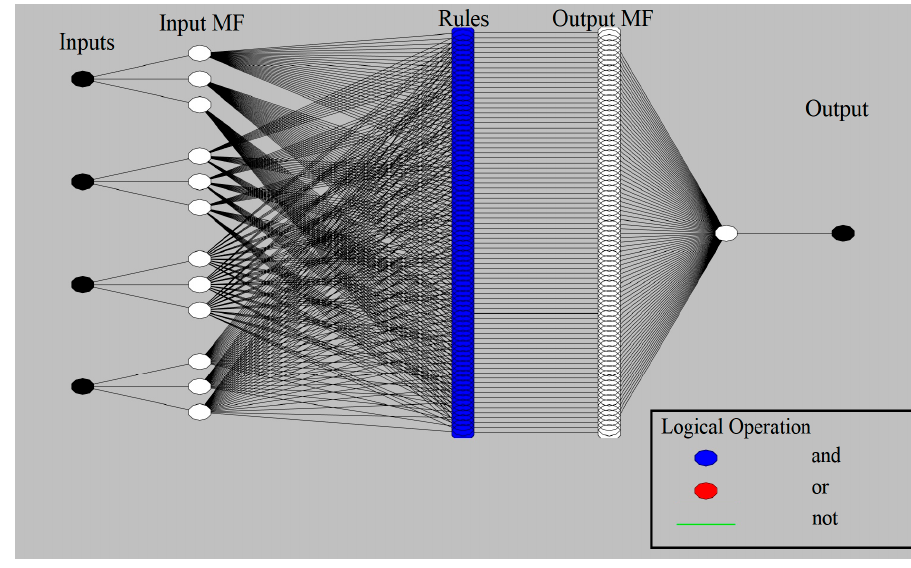
Figure 3. Architecture of the developed ANFIS.